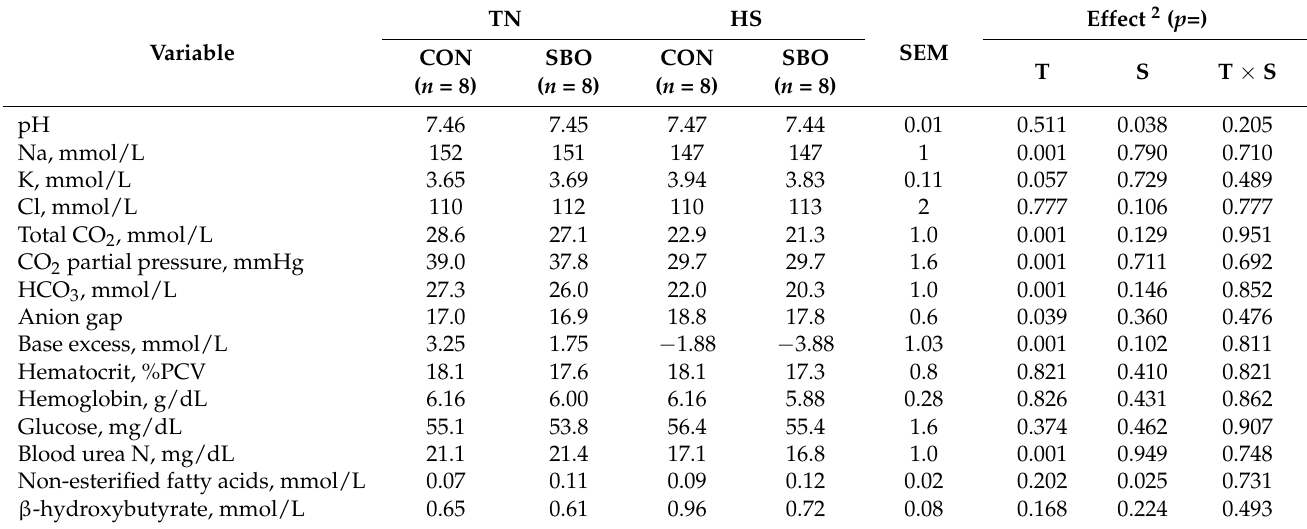
Table 5. Least squares means for blood metabolites in dairy goats under thermoneutral (TN) and heat stress (HS) conditions. In each ambient temperature, goats were fed a control diet (CON) or supplemented with soybean oil (SBO) 1 .